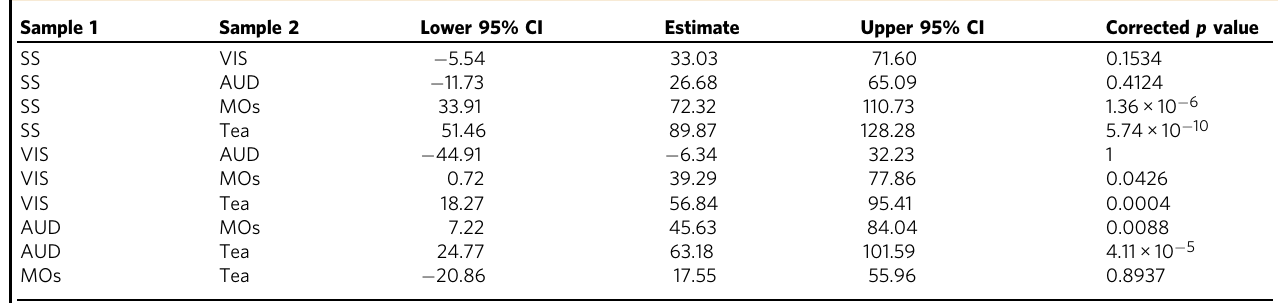
Table 3 Multiple comparison tests for PV regional